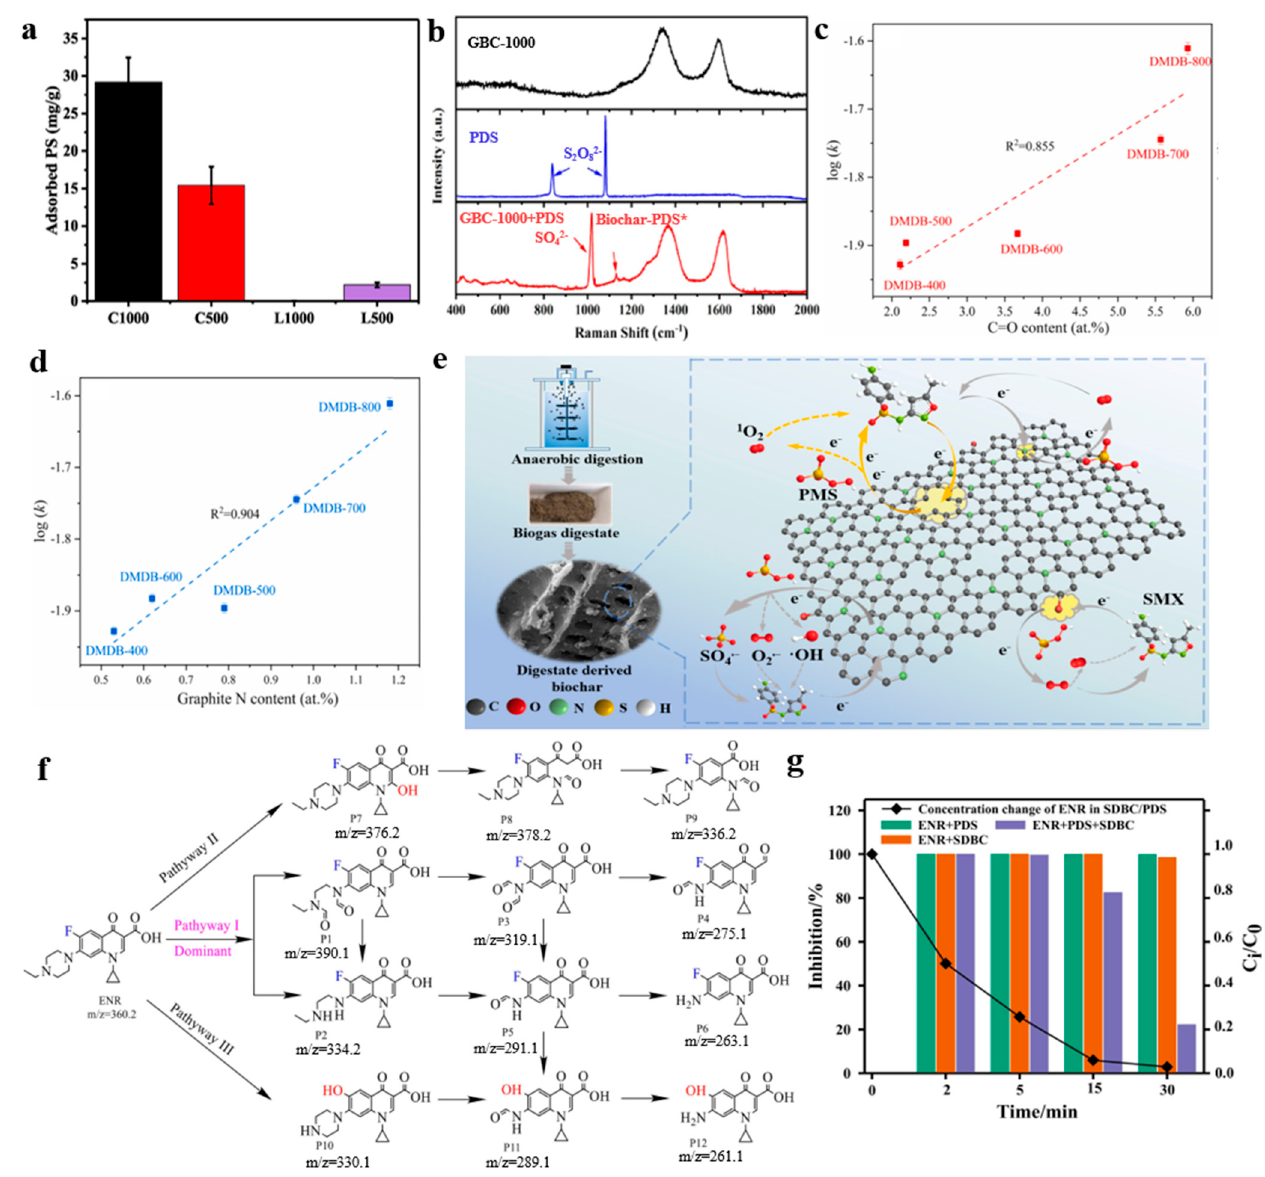
Figure 1. ( a ) The amounts of persulfate (PS) adsorbed on cellulose and lignin–derived biochar pre- pared at 500 or 1000 °C (C500, C1000, L500 and L1000). Reproduced with permission from [55]. ( b ) In situ Raman spectra of graphitic biochar prepared at 1000 °C (GBC-1000). Reproduced with permission from [49]. Sulfamethoxazole degradation rate in a log (k) versus ( c ) C=O content; ( d ) graphite N con- tent. ( e ) Mechanism scheme of sulfamethoxazole removal in dairy manure digestate–derived biochar (DMDB)/PMS system. Reproduced with permission from [19]. ( f ) Possible degradation pathways of enrofloxacin in sludge–derived biochar (SDBC)/PDS system. ( g ) The toxicity of enrofloxacin